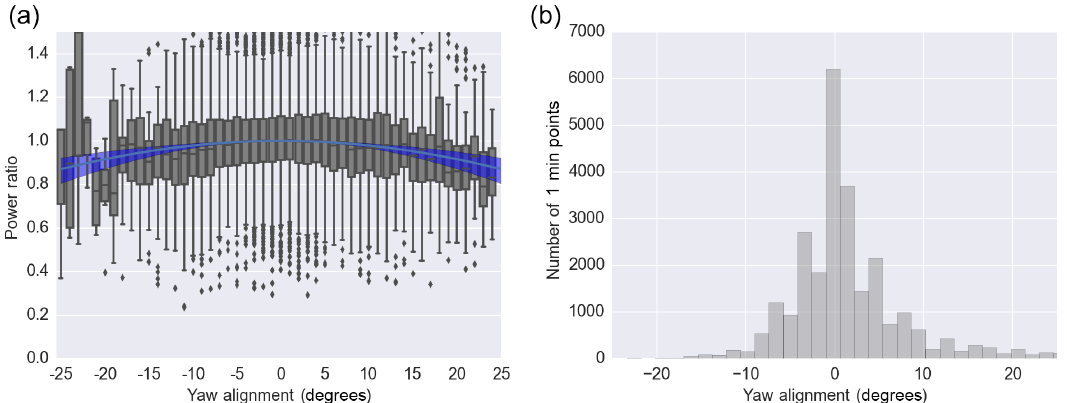
Figure 4. Cosine exponent fit. Panel (a) shows the range of data over various yaw misalignments and the power ratio. The blue line indicates a cosine function with the fit exponent value of pP = 1 . 41, and the banded region indicates the confidence interval as described in the text. Panel (b) indicates the number of points included in each yaw alignment